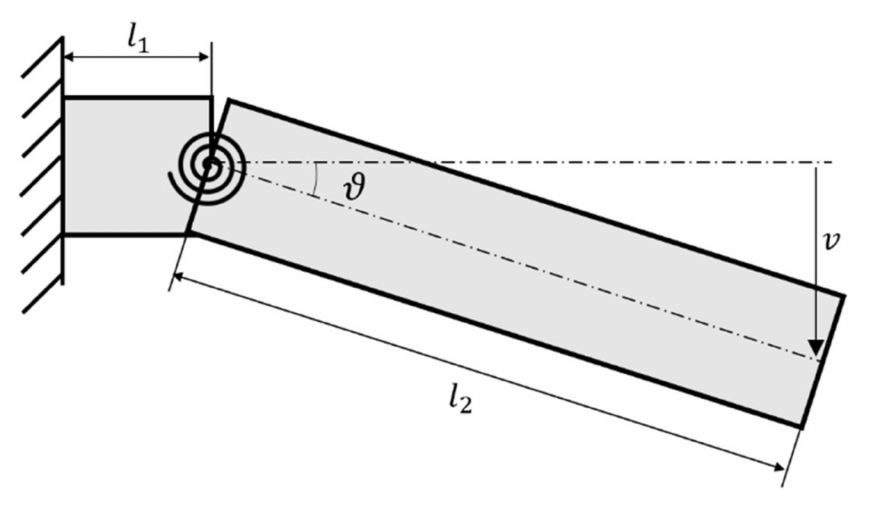
Figure 2. Inflatable link pseudo-rigid body model, 2D scheme.